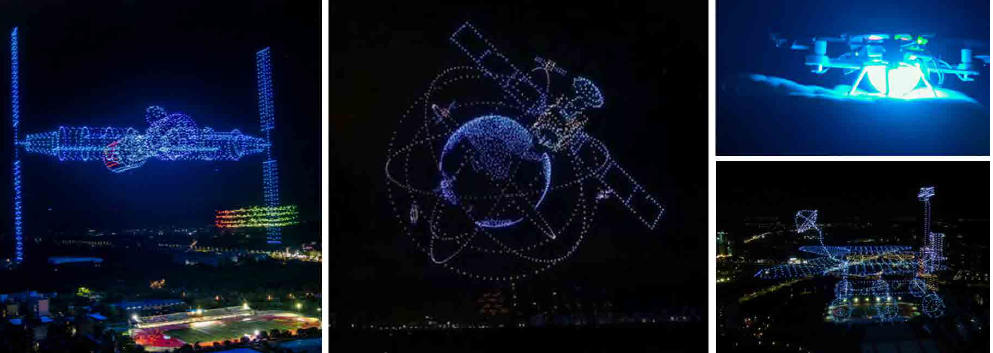
Fig. 13 The 3,051 UAS drone light show over the sky of